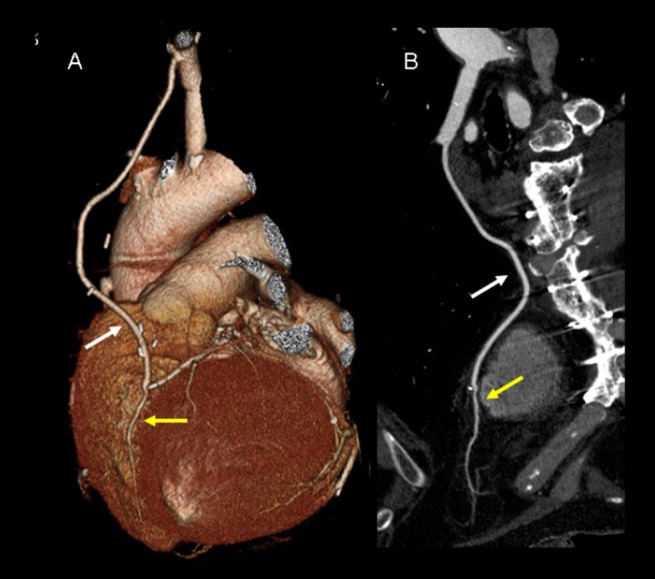
Coronary artery bypass graft – Non significant metallic artifacts.256-slice MDCT with prospective ECG-gating, volume rendering (A) and curve reformat (B), of a 77-yo man with a patent left internal mammary artery graft (IMA) (white arrows) on the left anterior descending artery (yellow arrows) (postoperative follow-up of 14 months). The scores for image quality in proximal, middle and distal graft segments were 5 (excellent), 5 and 5, respectively, for both 2 independent observers. Neither the artifacts from the surgical clips near the IMA (A) or from the sternal metallic wires (B) were reported as significant by any of the observers. Mean heart rate was 38 bpm. Heart variability (standard deviation of heart rate) was 1.0 bpm.